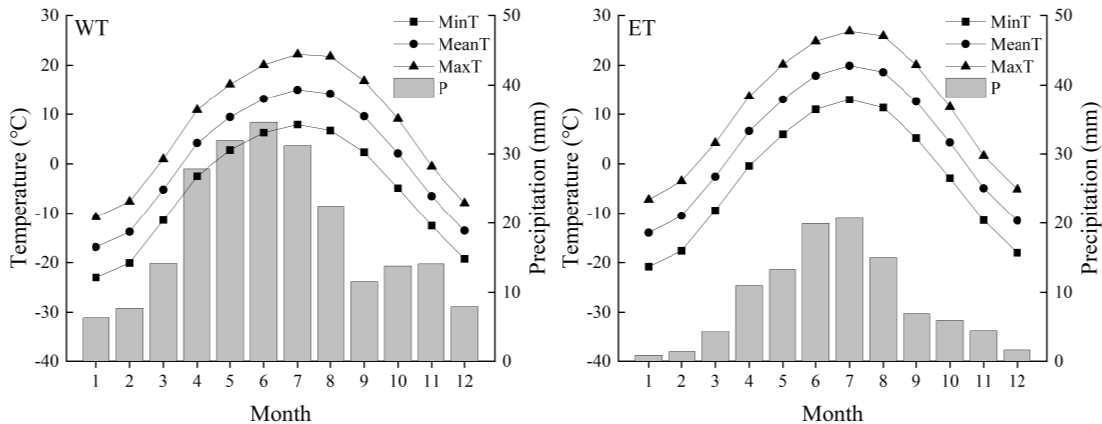
Figure 2. The monthly mean minimum (MinT), mean (MeanT) and mean maximum (MaxT) temperatures and monthly precipitation (P) during 1960–2019.